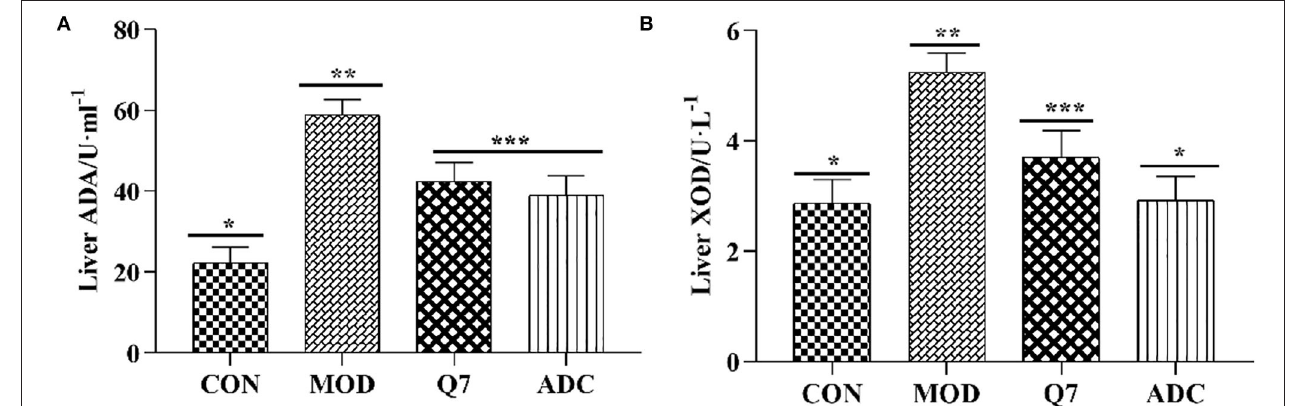
FIGURE 6 | Effects of L. plantarum Q7 on metabolism enzyme of mice. (A) Liver ADA; (B) Liver XOD.